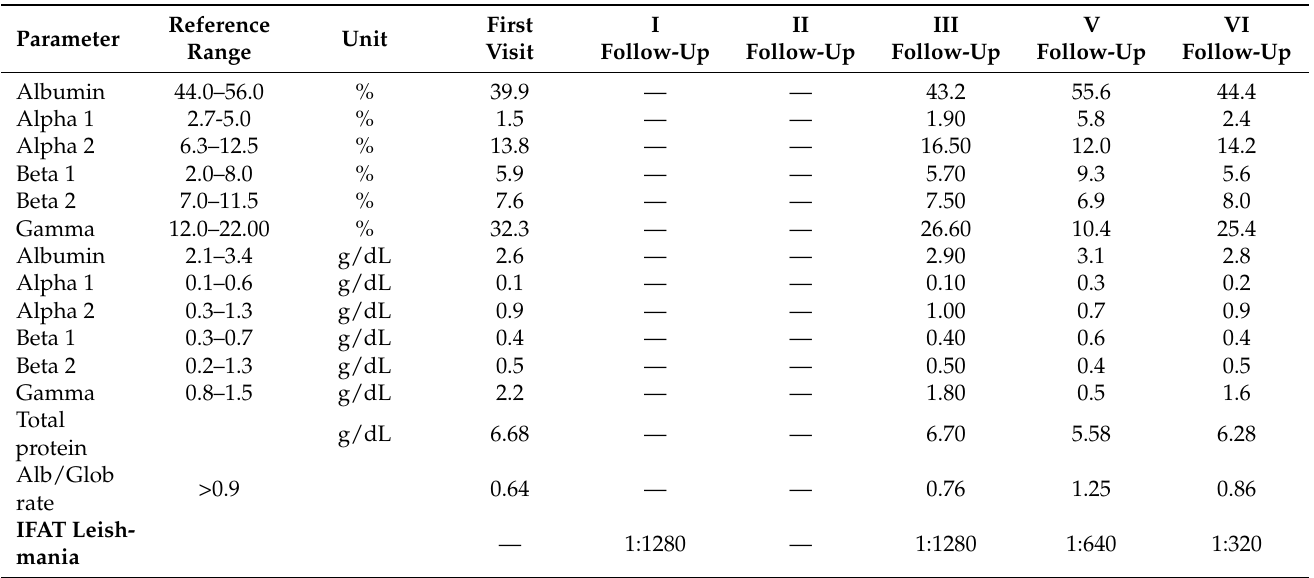
Table 3. Values of serum protein electrophoresis performed in a cat affected by FeL during the study